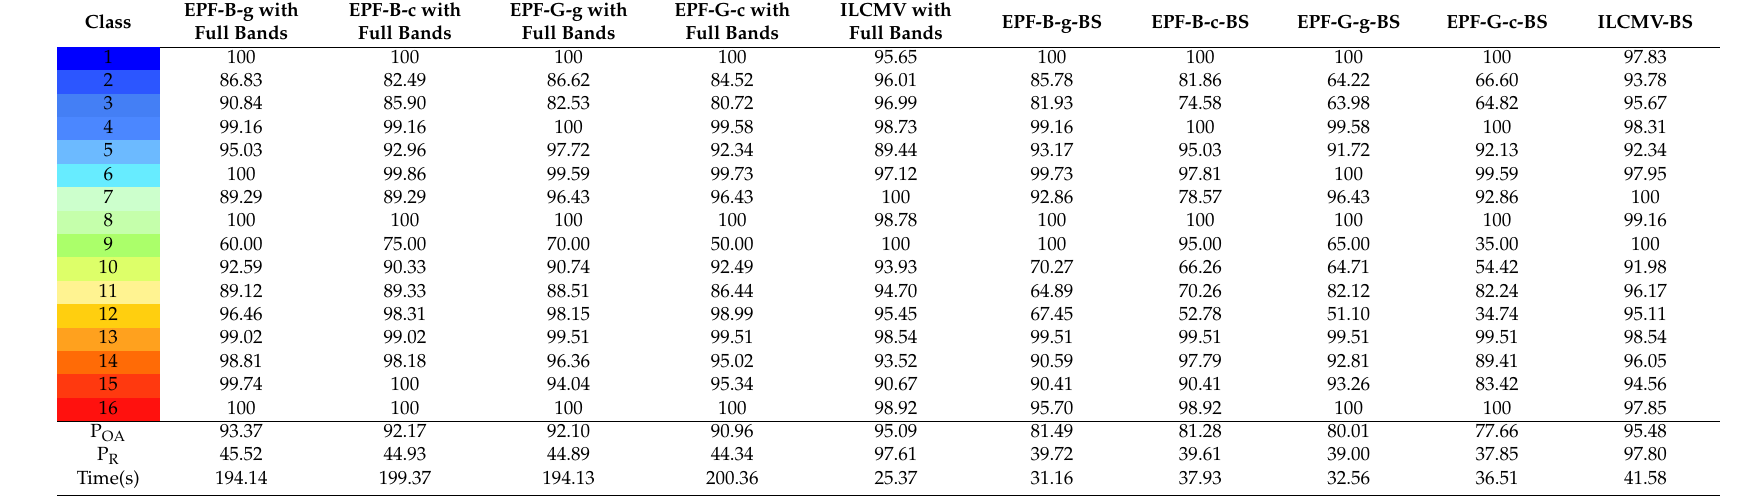
Table 8. P OA and P R calculated by the classification results using full bands and the bands selected by SQ LCMV-BSS-2 for the Purdue